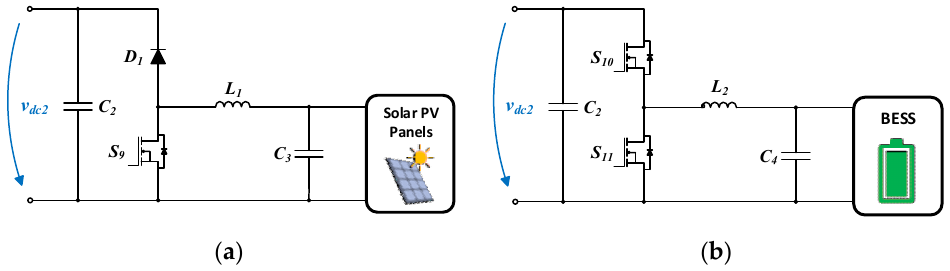
Figure 3. Electrical schematic of the non-isolated dc–dc back-end power converters: ( a ) Unidirectional boost, interfacing the solar PV panels; ( b ) bidirectional buck–boost, interfacing the BESS.